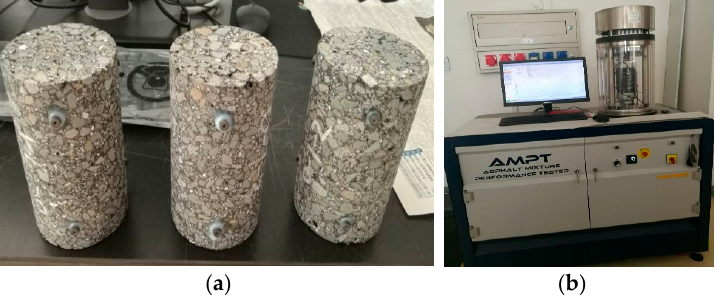
Table 4. The stress level (kPa) of dynamic modulus (DM) test.